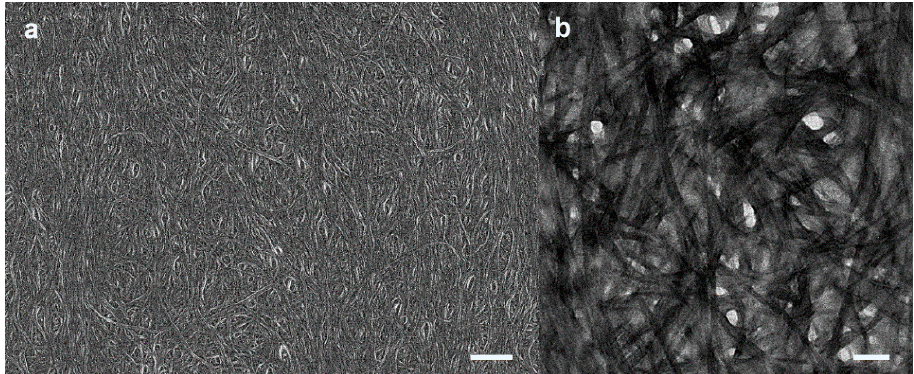
Figure 2. Microscopic images of the supramolecular thin film consisting of the self-assembled structures of TSADA from benzene solution (1 mg / mL) obtained by solution casting. ( a ) FE–SEM image of the supramolecular thin film. Scale bar, 1 µ m. ( b ) TEM image of the supramolecular thin film. Scale bar, 200 nm.